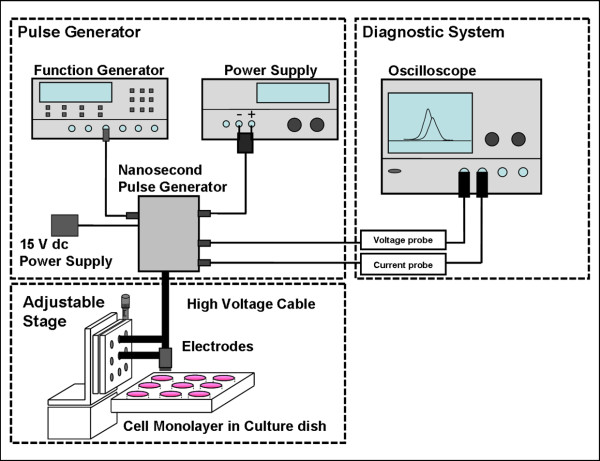
Schematic of the experimental setup for nanosecond pulsed electric field mapping.